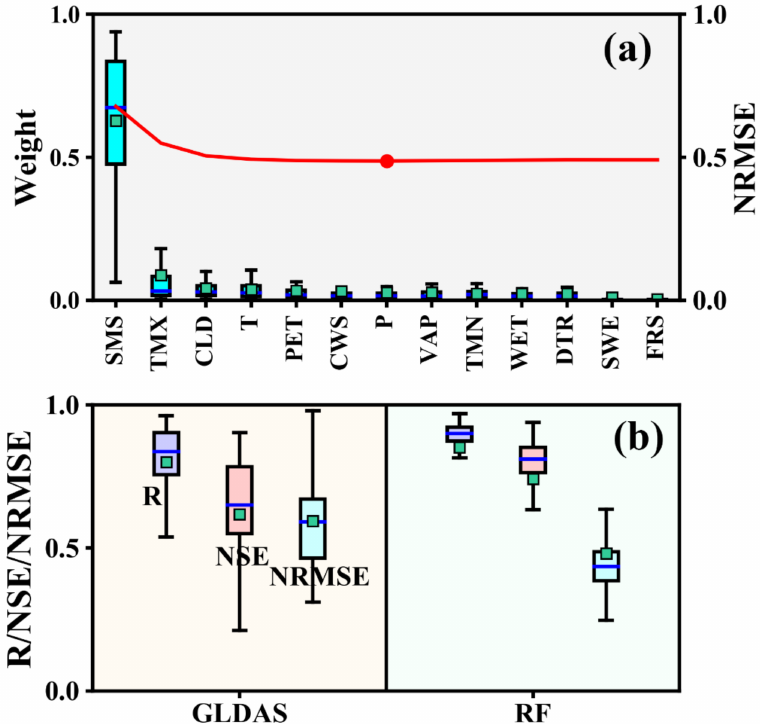
Figure 3. Grid-scale analysis in the Lancang-Mekong River basin for 2003–2014. ( a ) Relative weight of the variables in the RF models; the red line represents the model error. ( b ) Comparison between the GLDAS and RF models; the left (right) panel shows the boxplots of R, NSE, and NRMSE calculated from the GRACE TWSA and GLDAS TWSA time series (RF-built TWSA time